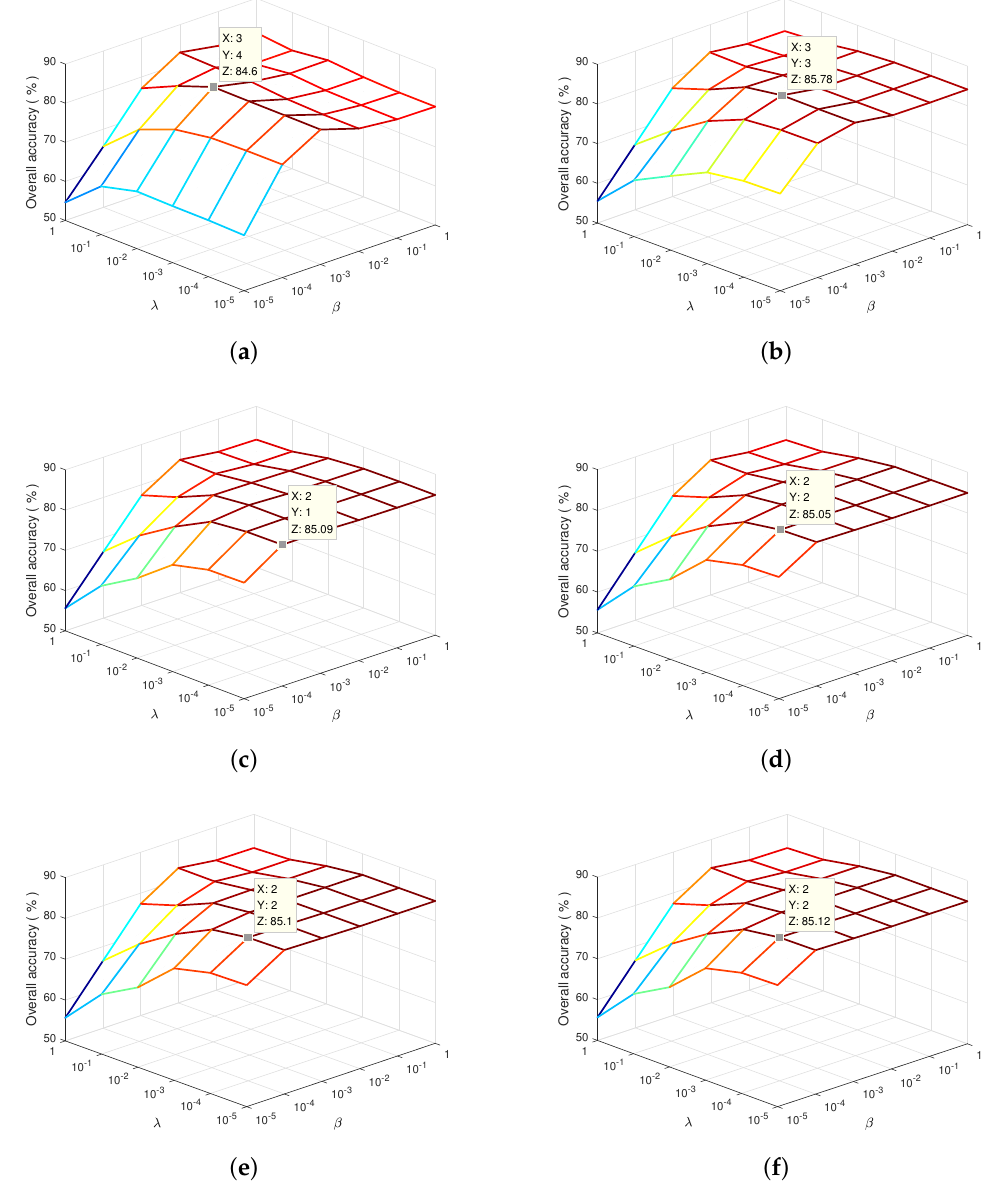
Figure 2. Parameter analysis of β , λ with different γ for the Indian Pines data: ( a ) γ = 1, ( b ) γ = 0.1, ( c ) γ = 0.01, ( d ) γ = 0.001, ( e ) γ = 0.0001, ( f ) γ =